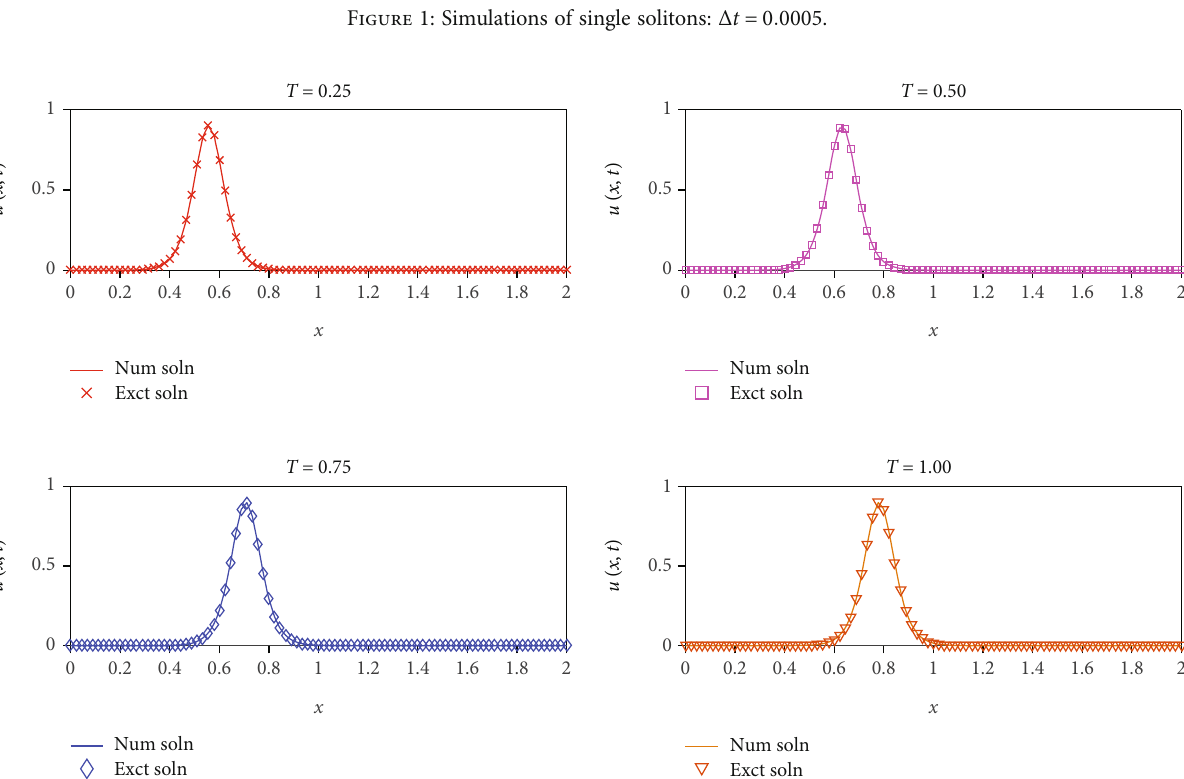
Figure 2: Simulations of single solitons: Δ t = 0 : 001